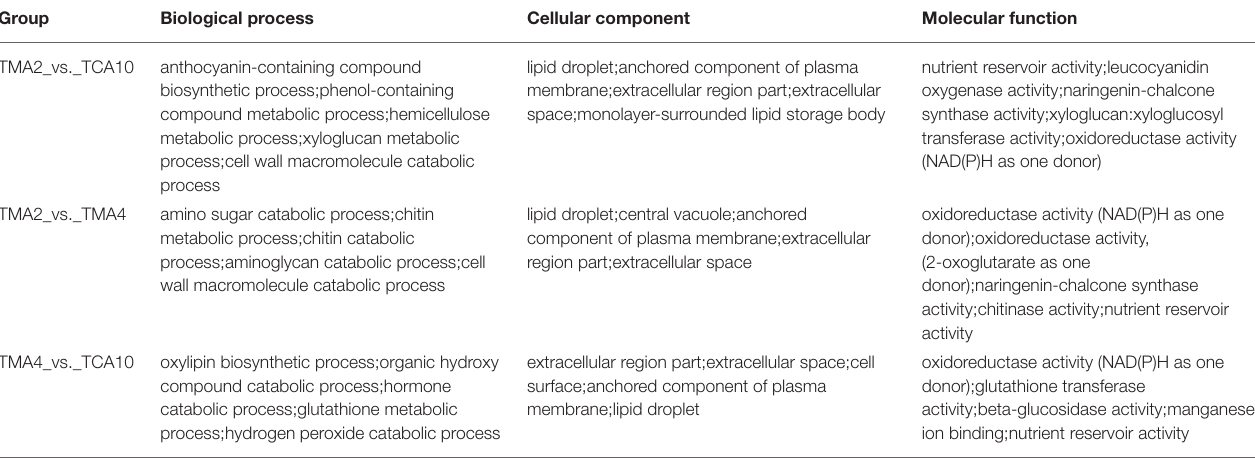
TABLE 1 | The five most significantly enriched GO terms in the enrichment hierarchical analysis of DEGs.